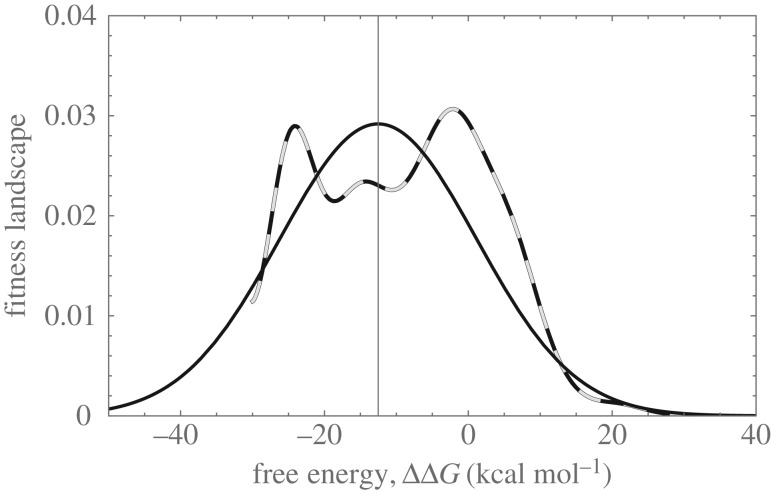
Empirical approximation of a stabilizing selection landscape. Dashed line denotes empirical landscape (using only data for single substitutions in the ancestral node). Black: Gaussian landscape with parameters inferred from the empirical landscape. Note that the scale of the landscape is of arbitrary units, and in this case both functions were normalized. For details on the method of estimating the landscape, see the electronic supplementary material, S5. Results based on FoldX dataset.